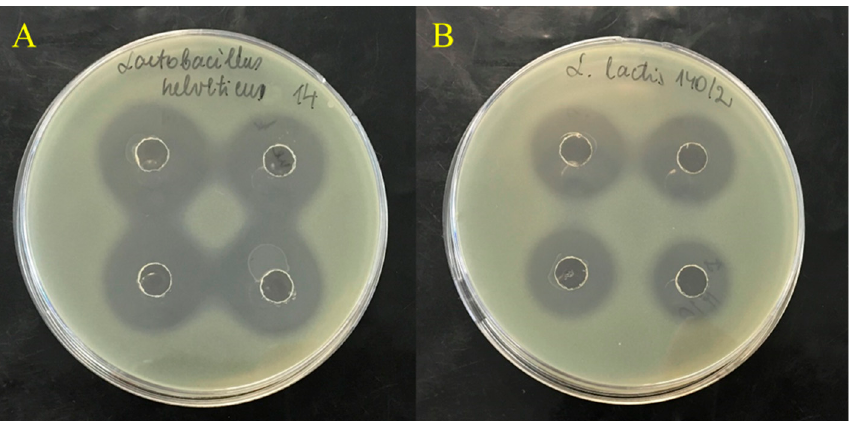
Figure 2. Antibacterial activity of Lb. helveticus 14 ( A ) and L. lactis 140/2 ( B ) strains against X. arboricola NRCIB X7.